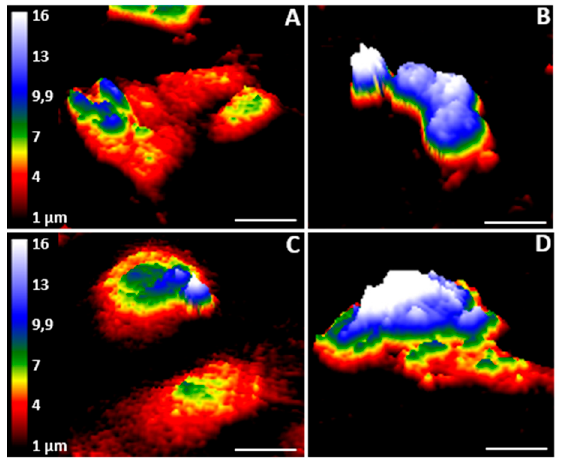
Figure 3. 3D holograms presenting the untreated MCF-7 cells ( A ), MDAMB231 ( C ) and the treated MCF-7 cells ( B ), MDAMB231 ( D ) with 0.04 mg/mL of SA-MIPs after 72 h incubation. The colour scale represents the thickness and the scale bar represents 20 µm.